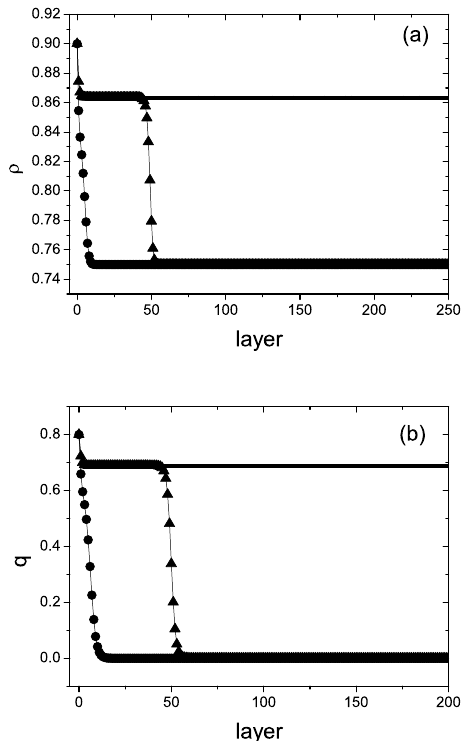
Figure 4. PS case profiles for a = 0: ( a ) occupancy and ( b ) orientational order parameter. Ordered solutions for θ = 1.62 (continuous lines) and disordered solutions (circles and triangles). Circles: θ = 1.69, triangles: θ = 1.62, corresponding to the high and low temperature ends of the first order